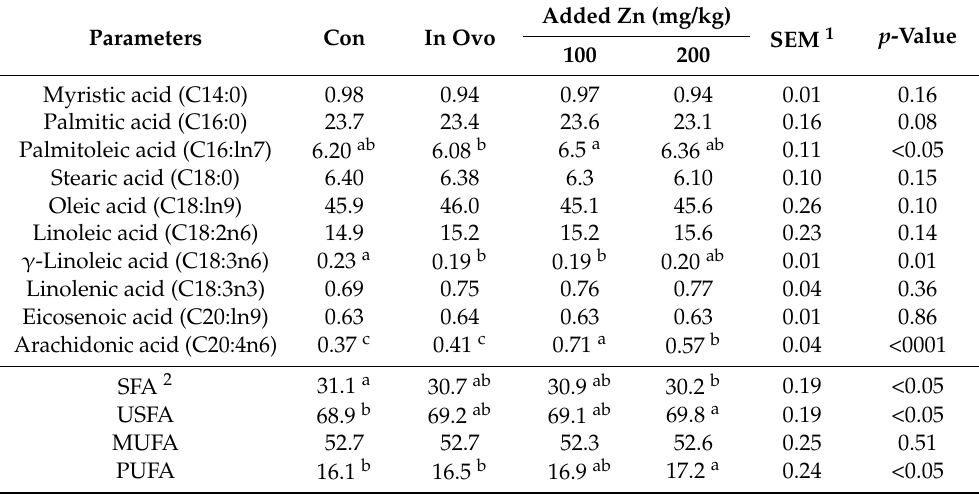
Table 6. Effect of in ovo injected and supplemental Zn on fatty acid composition of breast meat in broilers at 35 days of